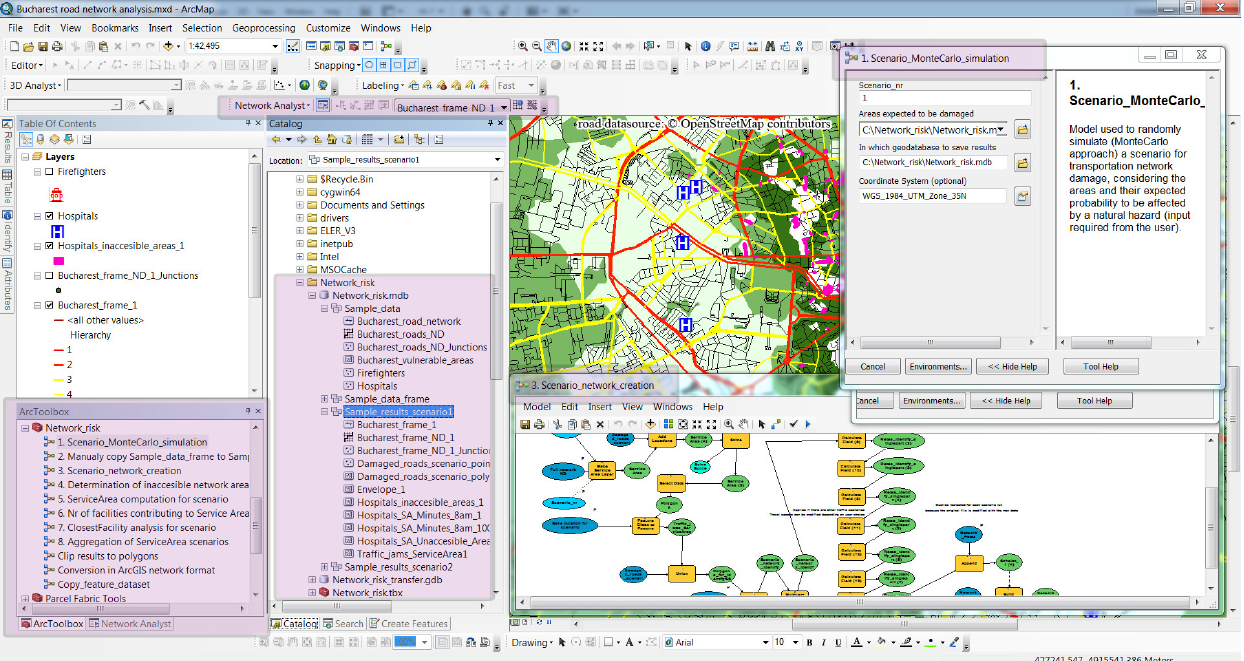
Figure 2. Screen capture of ArcGIS Desktop ArcMap with Network-risk toolbox added, contributing to the analysis of Bucharest’s road network risk analysis; the framework of one of the models (3. Scenario_network_creation) can be seen as well as the model run interface (1. Scenario_MonteCarlo_simulation), the Network-risk toolbox modules and the sample data results created using these modules (high- lighted in